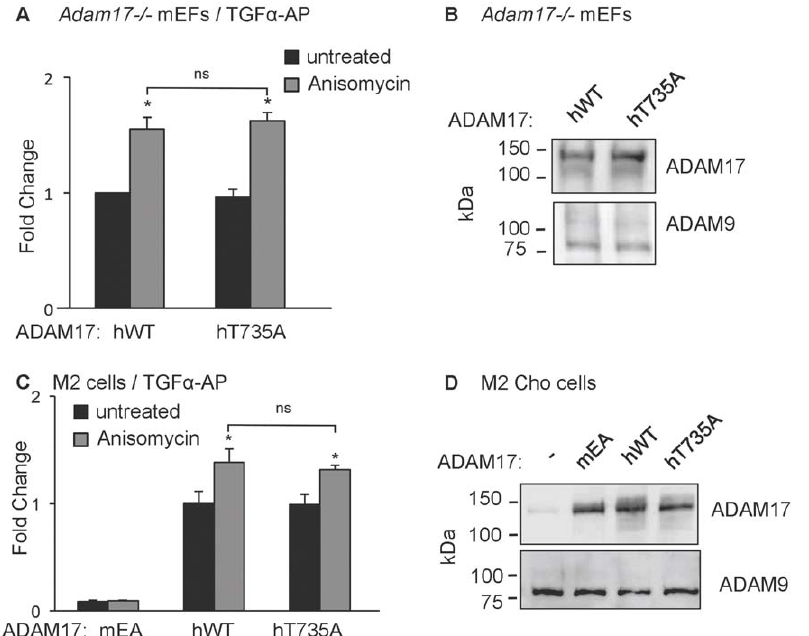
Figure 3. Comparison of TGF a shedding by human wild type ADAM17 and the T735A mutant. A) Adam17 2 / 2 mEFs were transfected with TGF a -AP together with human wild type ADAM17 (hWT) or the human ADAM17-T735A mutant (hT735A). TGF a -AP shedding was measured in supernatants conditioned for 30 minutes on untreated cells (black bars) or cells treated with 1 m M anisomycin (grey bars). There was no significant difference between constitutive or anisomycin-stimulated shedding by hT735A compared to hWT ADAM17. B) Western blot analysis with antibodies against the cytoplasmic domain of ADAM17 demonstrated comparable expression of hWT and hT735A, with ADAM9 serving as a loading control. C) M2 CHO cells carrying inactivating mutations in both alleles of ADAM17 [37] were transfected with TGF a -AP and the inactive mouse ADAM17EA to provide a negative control, or hWT or hT735A. Basal shedding of TGF a -AP was restored to comparable levels by the introduction of either hWT or hT735A. The stimulation of hWT and hT735 by 1 m M anisomycin was weaker in M2 CHO cells than in Adam17 2 / 2 mEFs rescued with these constructs, but there was no significant difference between the anisomycin-stimulated shedding by these two constructs. D) Western blot analysis of M2 CHO cells with anti-ADAM17 cytotail antibodies shows the expression of the endogenous mutant forms of ADAM17 in untransfected cells, and similar expression levels of murine ADAM17EA (mEA) compared to human WT or T735A ADAM17. The results in panels A and C represent the average of at least 3 experiments + / 2 sem. Asterisks indicate significant increase upon addition of a